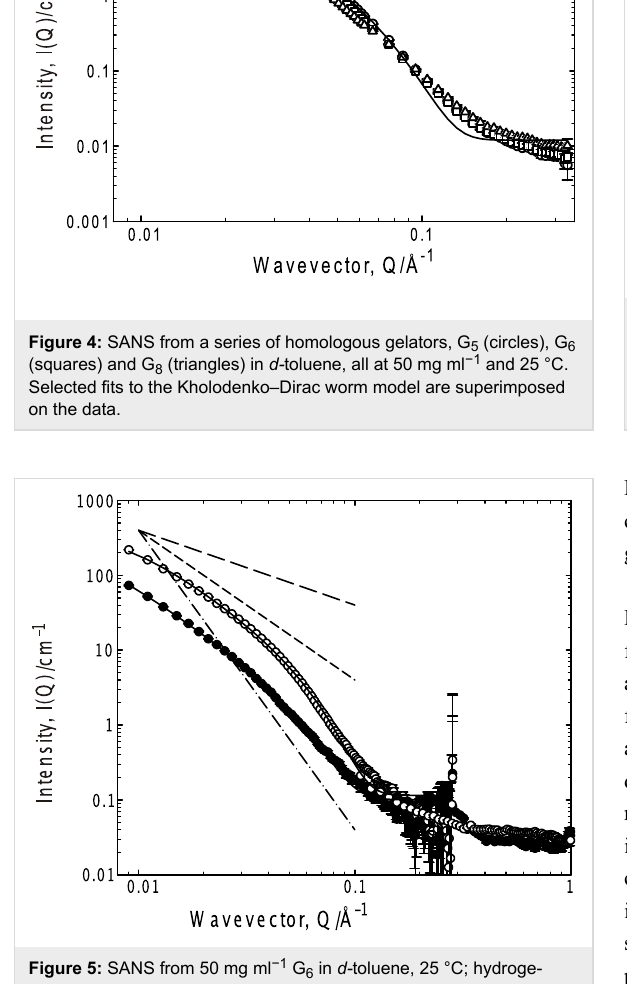
Figure 5: SANS from 50 mg ml − 1 G 6 in d- toluene, 25 °C; hydroge- nous gelator (empty symbols) and partially deuterated gelator (filled symbols). Fits to the Kholodenko–Dirac worm model are superim- posed on the data. Limiting behaviors of Q − 1 , Q − 2 and Q − 4 are also shown.